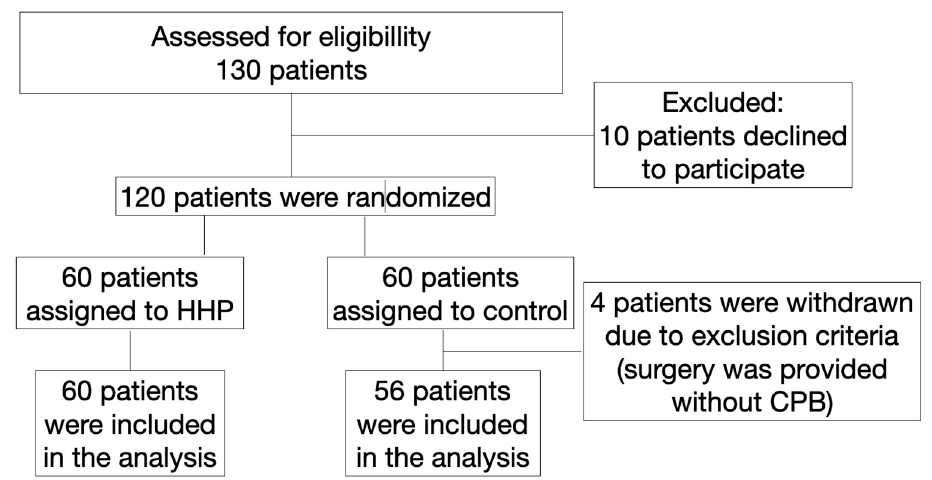
Figure 1. Flowchart of patient enrollment. HHP—hypoxic–hyperoxic preconditioning; CPB—car- diopulmonary